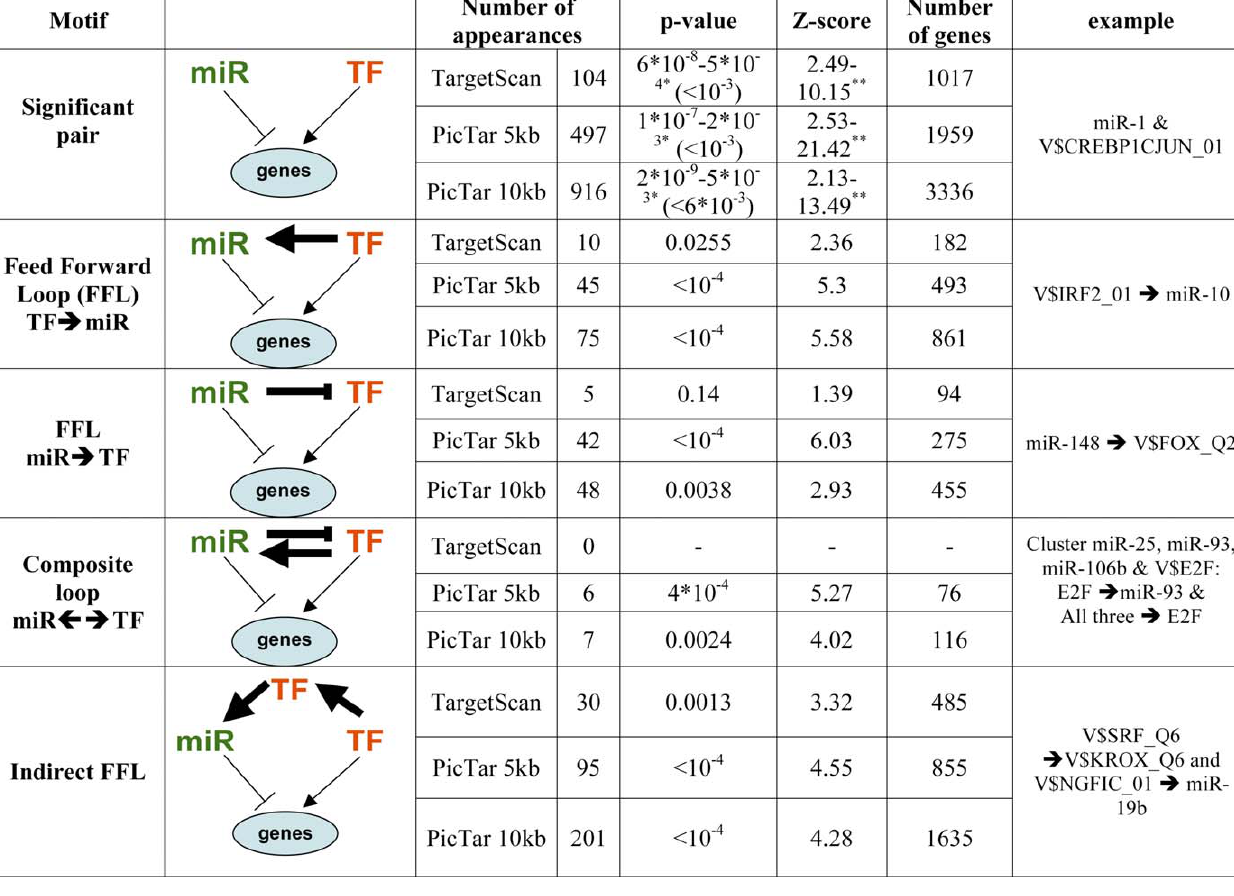
Figure 4. Network Designs in the miR–TF Coregulation Network The figure depicts the analyzed network motifs in the TargetScan and PicTar dataset, and with the use of TF binding sites in RefSeq genes promoters of 10 kb for both networks, and 5 kb for the PicTar network. The figure depicts, for each network motif, its architecture, the number of times it appears in each of the networks, the p -value and z-score for its over-representation in the network (as described in Materials and Methods), the total number of RefSeq genes that are regulated by this type of network design, and an example. *For the first design, the coregulating miR–TF pair, we state the range of hypergeometric p -values of pairs that passed FDR and are considered significant, and in brackets the FDR p -value of these pairs using the randomization co-occurrence test. **In addition, z-scores for significant pairs were calculated based on the co-occurrence edge-swapping randomization model (see Materials and